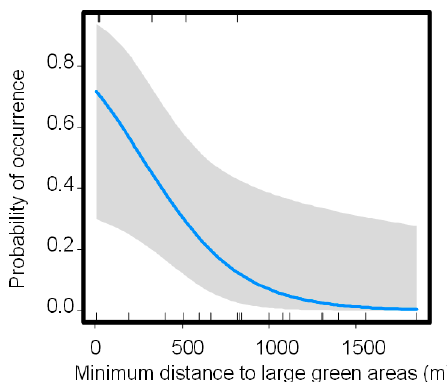
Figure 2. Harris hawk probability of occurrence in urban green areas in relation to the minimum distance to green areas of more than 5 ha (Dist2) in Buenos Aires city, Argentina. The vertical lines are distances between sampling sites with a presence (above X-axis) or absence (below X-axis). The blue line represents the fitted curve, and the grey area represents the confidence intervals at 95%.